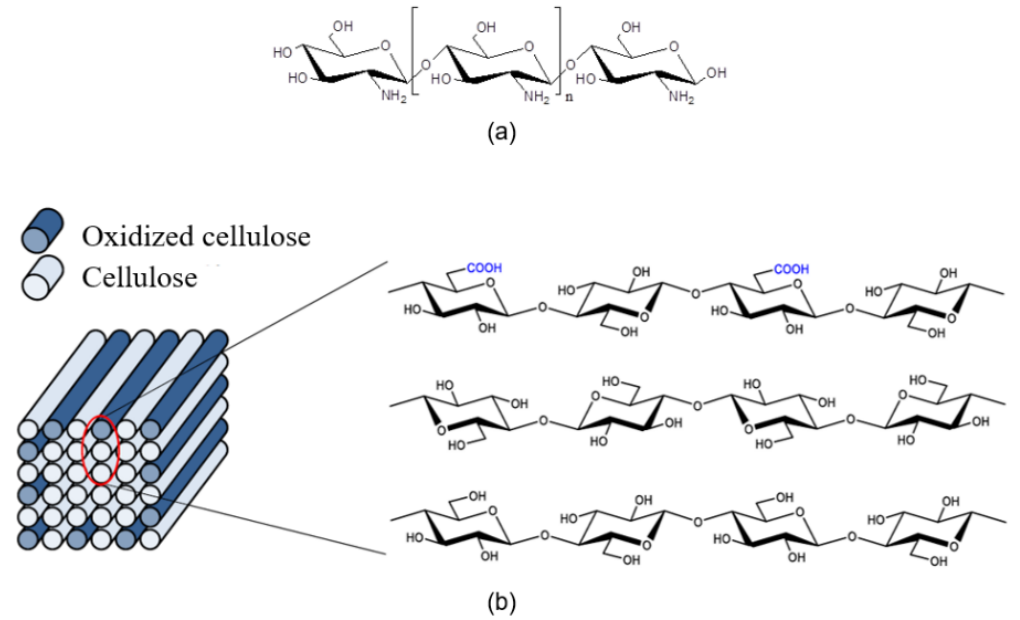
Figure 1. Wet-spinning apparatus and spinning conditions. 2.3. Preparation of CS/TOCN Composite Fiber with Various TOCN Concentration To investigate the effect of the TOCN content on the tensile properties and spinning ability, the NaOH concentration was fixed at 2%, while the TOCN concentrations were varied as 0, 0.001, 0.0075, 0.01, 0.05, and 0.1%. The chemical structure of CS and the cross-sectional structure of TOCN are shown in Figure 2.